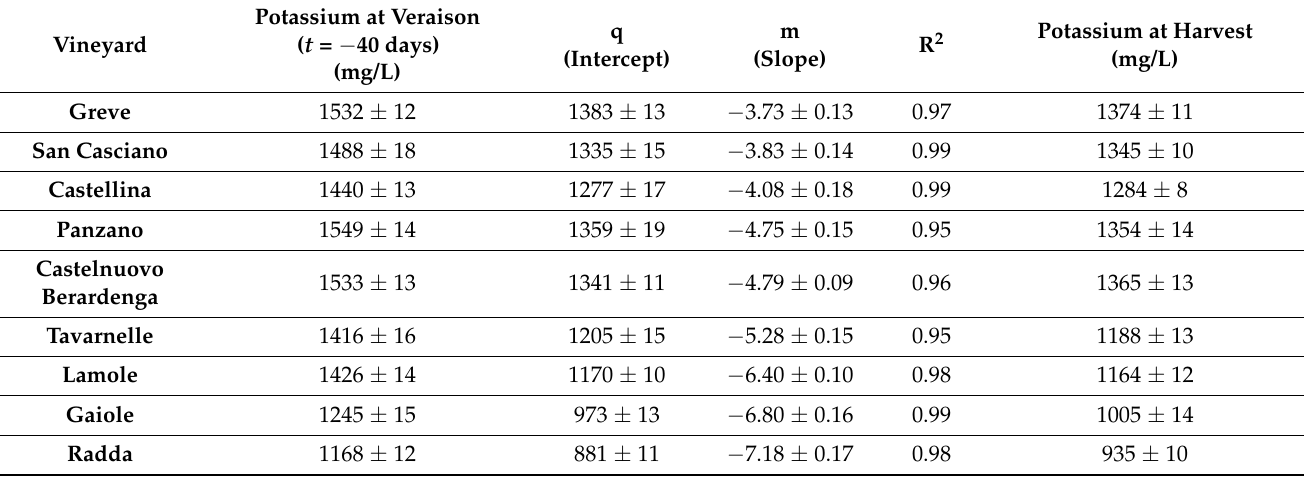
Table 9. Calculated values of the functional parameters, intercept, slope and R 2 of the potassium inside the grapes coming from the different